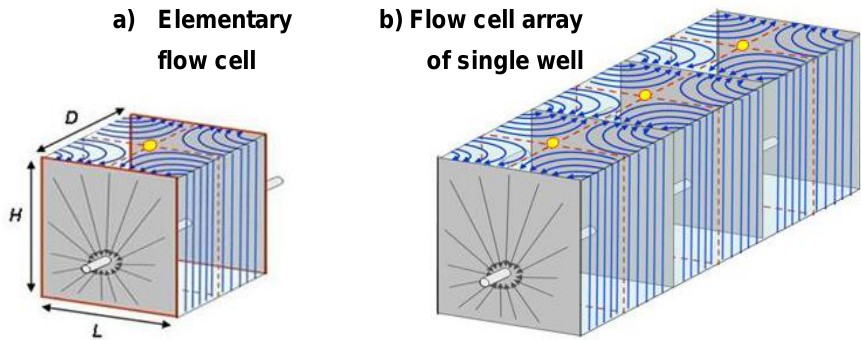
Figure 1. ( a ) Principle sketch of flow cells in single well. Blue lines are streamlines in flow cell between two sub-parallel hydraulic fractures. ( b ) Three flow cells in a partial section of a single horizontal well. Dashed lines are flow separation surface. Yellow dots represent stagnation points. D is fracture spacing, H pay height, and L hydraulic fracture length. After [7].